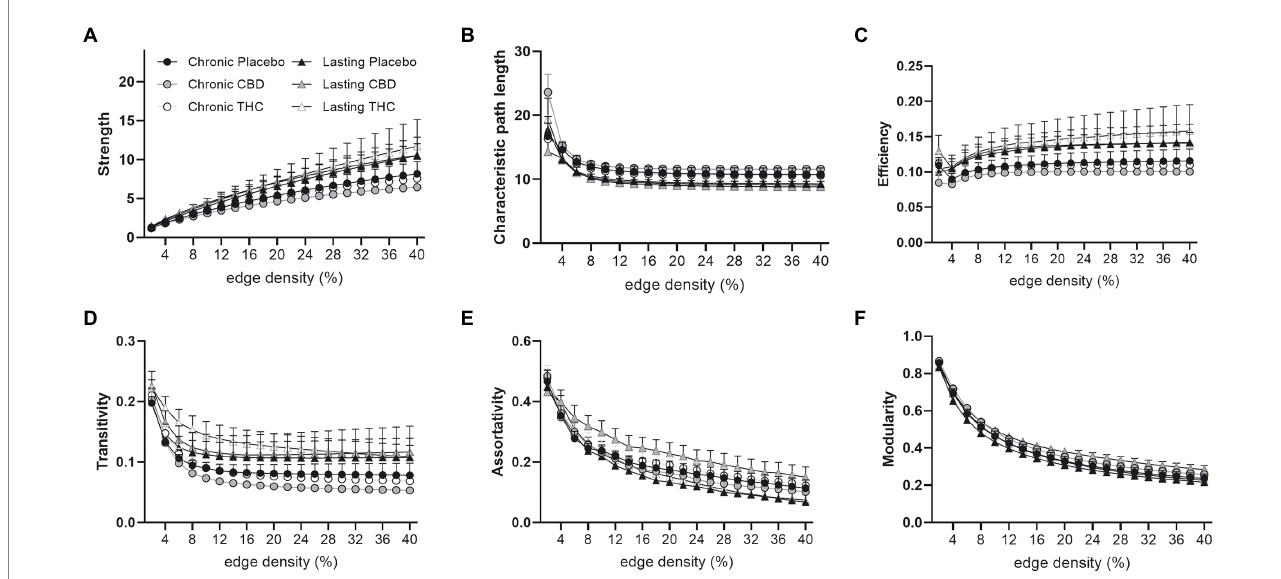
FIGURE 7 Functional network topology. Functional network topological measures in mice chronically administered vehicle, CBD, or THC 28 days and imaged immediately after (chronic) and after a 2-week washout period (lasting). The network measures shown include (A) node strength, (B) characteristic path length, (C) efficiency, (D) transitivity, (E) assortativity and (F) modularity. All network measures are plotted as a function of edge density threshold (data are shown as mean ± standard error).